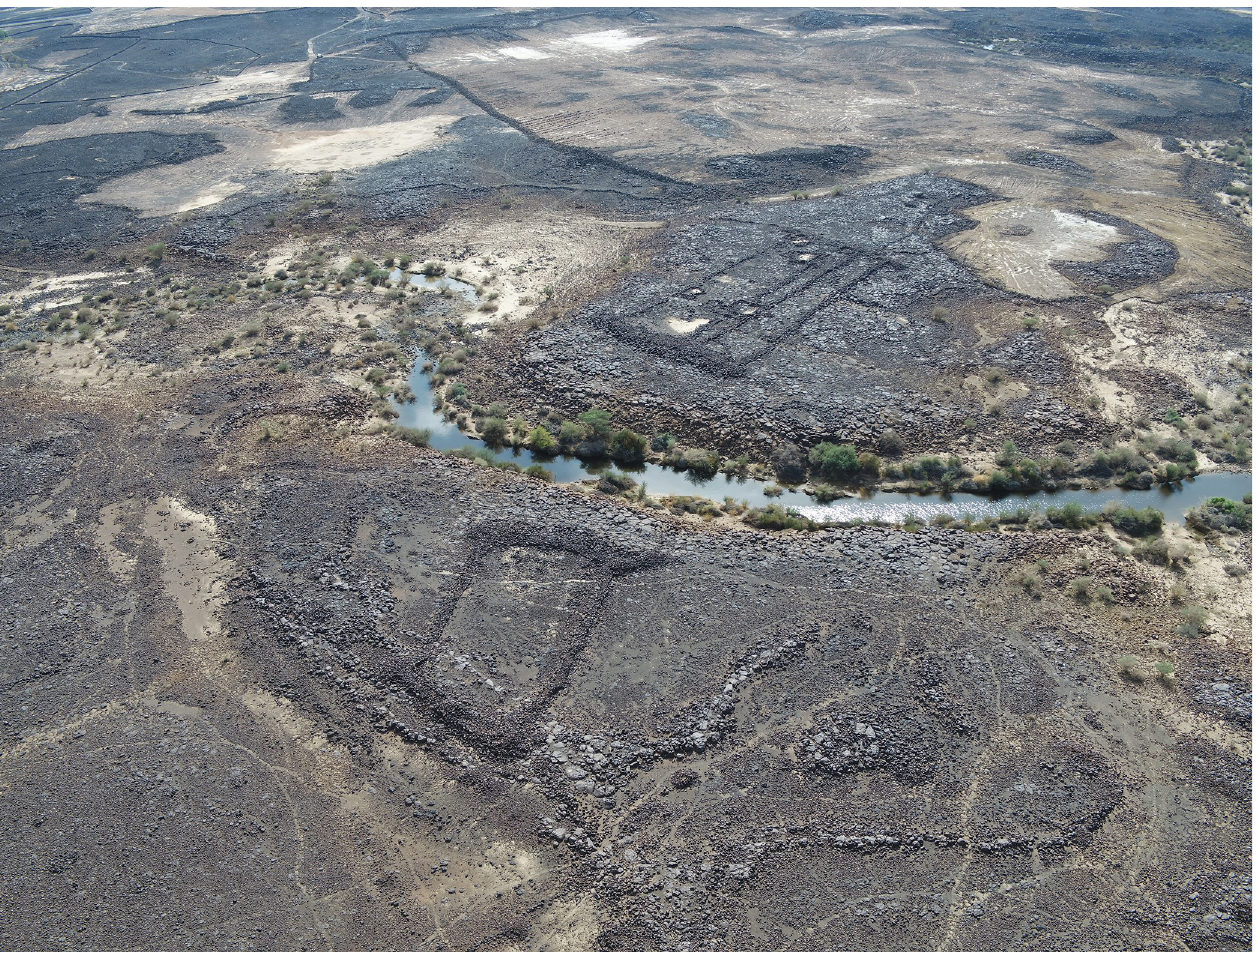
Fig 27. Three mustatil at site IDIHA-0030914, orientated (base) towards a small seasonal wadi in Khaybar County, photo orientated